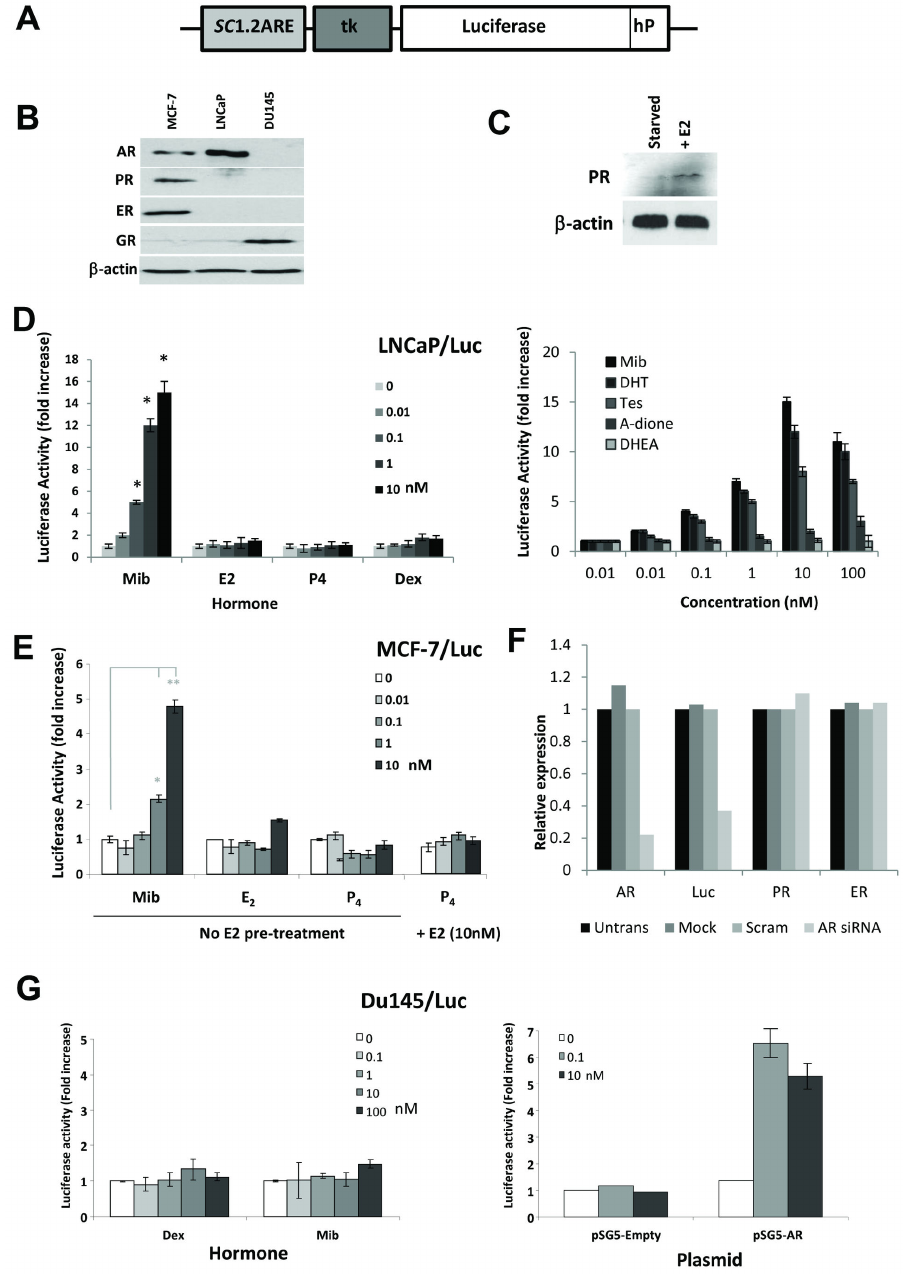
Figure 1. Analysis of the androgen receptor reporter construct in stably transfected cells. ( A ) Schematic representation of the ARE-tk-Luc androgen receptor reporter construct (hP = hPEST degradation signal). ( B ) Western blot analysis of steroid receptor expression in MCF-7, LNCaP and Du145 cells growing in full media. ( C ) Western blot analysis of PR expression in hormone starved MCF-7 cells -/+ E2 treatment for 24hr. ( D ), Luciferase activity from hormone treated LNCaP/Luc cells – treated for 24hours with 0-10nM mibolerone (Mib), estrogen (E2), progesterone (P4) and dexamethasone (Dex) (left hand side) and with 0-100nM of the androgens - (Mib), dihydrotestosterone (DHT), testosterone (Tes), androstenedione (A-dione) and dehydroepiandrosterone (DHEA) for 24 hours (right hand side). ( E ) Luciferase activity from hormone treated MCF-7/Luc cells – treated for 24hours with 0-10nM Mib, E2 or P4 or with additional 24hr pre-treatment with E2 (10nM) to induce PR expression. ( F ) Q-PCR quantification of relative expression of the steroid receptors AR, ER, and PR and luciferase transcripts in MCF-7/Luc cells, grown in full medium, transfected with siRNA against androgen receptor. ( F ) Luciferase activity from Du145/Luc cells treated with 0-100nM dex or mib (left hand side) or pre-transfected with an additional AR or empty vector expression constructs (right hand side). **P<0.01, *P<0.05 (t-test analysis). doi: 10.1371/journal.pone.0071694.g001 PLOS ONE |